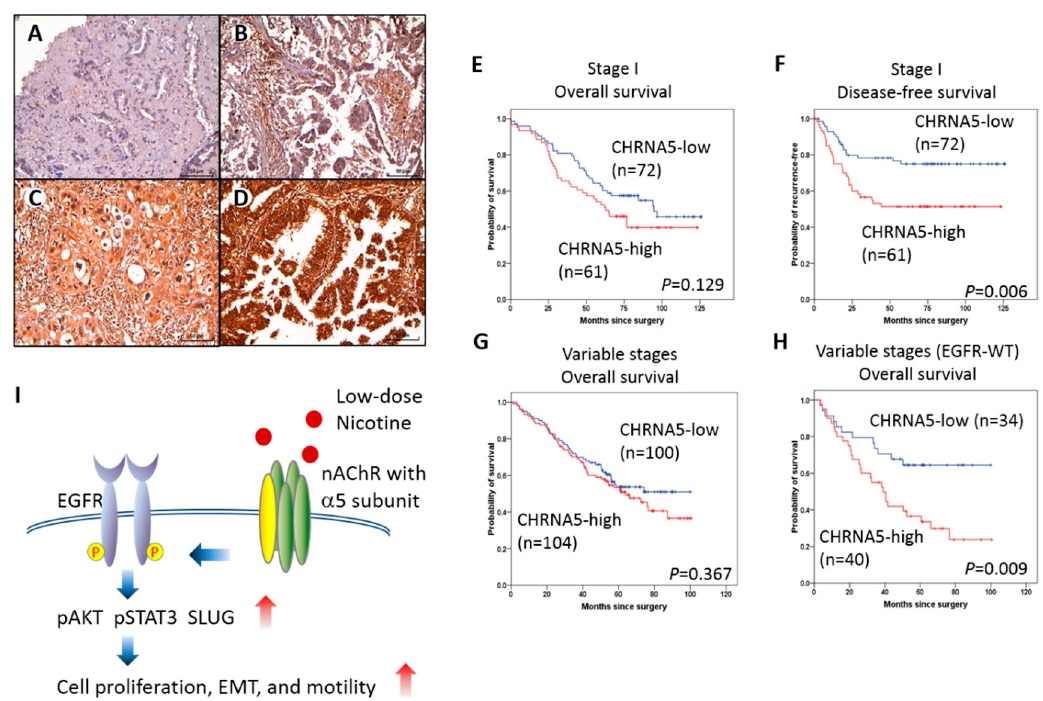
Figure 6. α 5-nAChR positively associated with poor survival of EGFR-wild-type LAC patients. ( A – D ) Pathological scoring of α 5-nAChR protein expression in LAC patients’ specimens: negative (d; intensity score = 0), weak expression (e; intensity score = 1), moderate expression (f; intensity score = 2), strong expression (g; intensity score = 3). Original magnification: 200×. Scale bar = 50 μ m. ( E) Kaplan-Meier analysis of the overall survival in stage I LAC patient cohort. ( F ) Kaplan-Meier analysis of postoperative disease recurrence in stage I LAC patient cohort. ( G ) Kaplan-Meier analysis of the overall survival in patients with EGFR-wild-type (WT) LAC at variable stages. ( H ) Kaplan-Meier analysis of the overall survival in patients with EGFR-mutant LAC at variable stages. ( I ) Schematic presentation of the α 5-nAChR mediated tumorigenesis effects of low-dose nicotine on lung adenocarcinoma in aspects of EGFR pathway activation, cell proliferation, epithelial-mesenchymal transition, and cell motility.